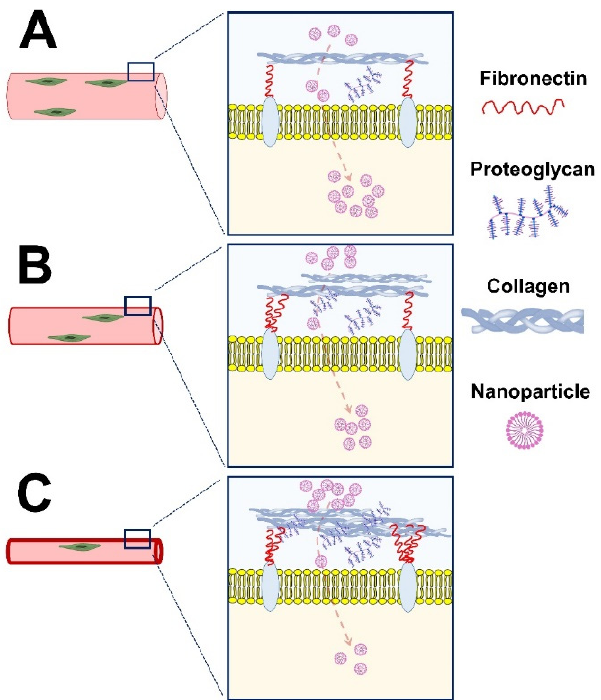
Figure 1. The penetration of nanoparticles in healthy ( A ) and dystrophic skeletal muscle with early ( B ) and advanced ( C ) dystrophy. The amount of extracellular matrix, including fibronectin, proteoglycans, and collagens, is a critical driver of nanoparticle penetration into skeletal muscle. The payload delivery and treatment success rates are higher in skeletal muscles with early vs. advanced